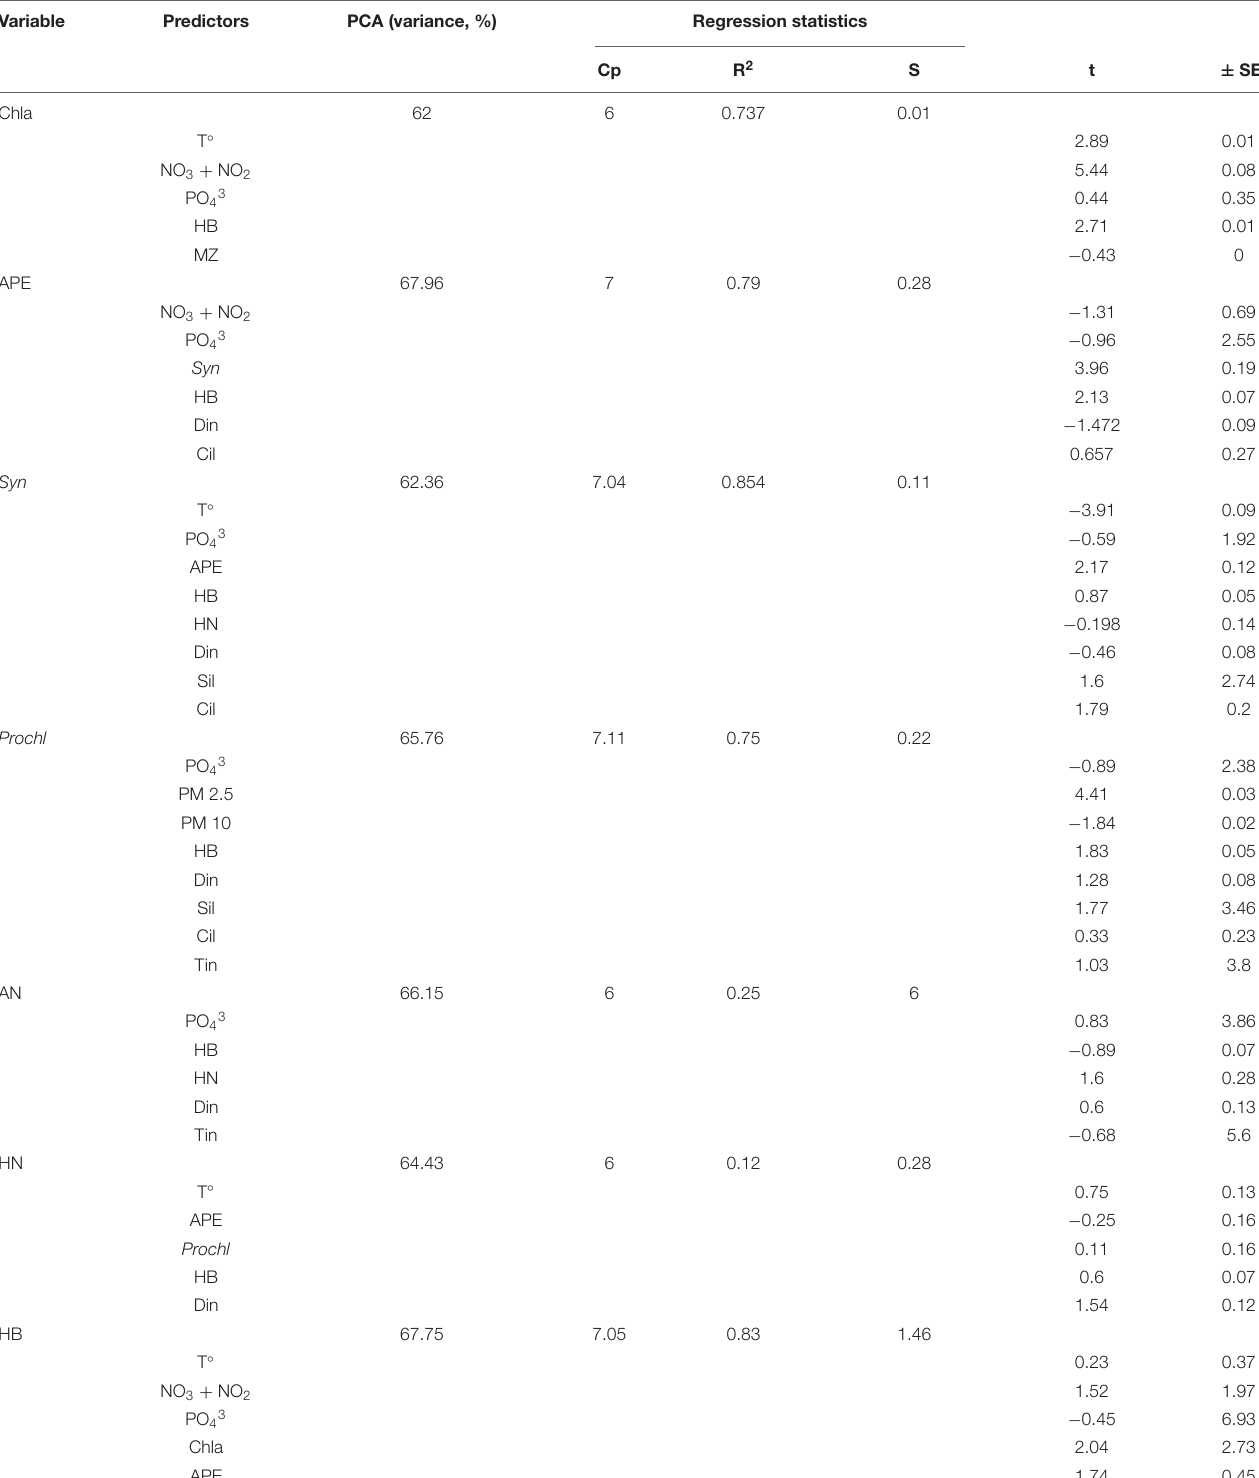
TABLE 1 | Principal Component Analysis (PCA) and Stepwise multiple regression model for groups of organisms using biological and physiochemical variables as effects: Temperature (T ◦ ), Chlorophyll a (Chla), autotrophic picoeukaryotes (APE), Synechococcus ( Syn ), Prochlorococcus ( Prochl ), autotrophic nanoflagellates (AN),